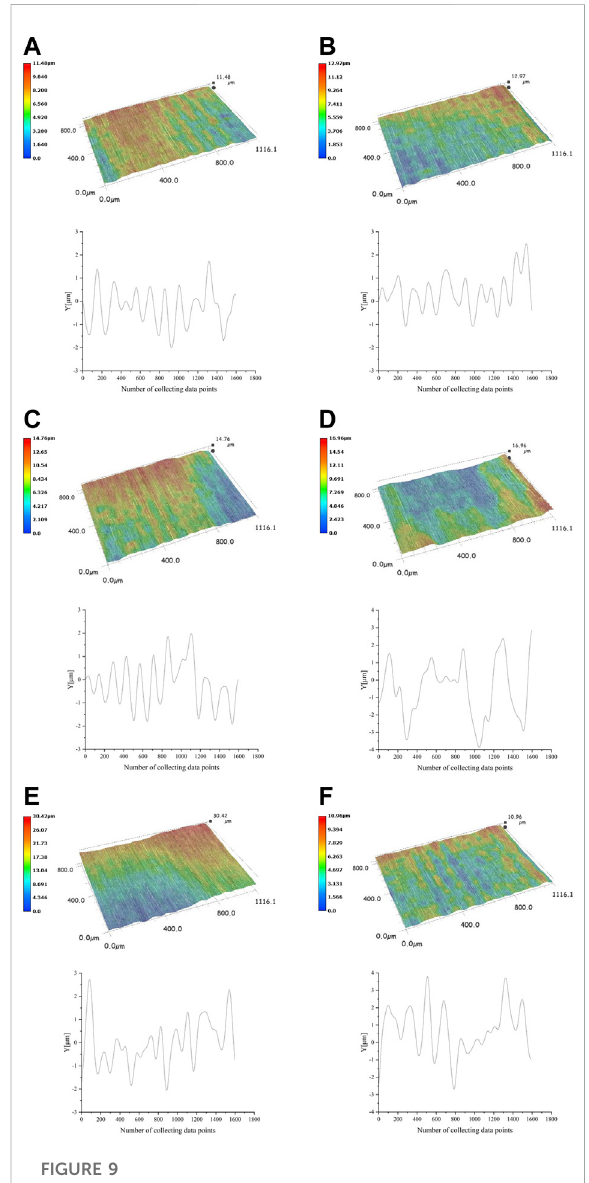
FIGURE 9 3D morphological results for different trajectory